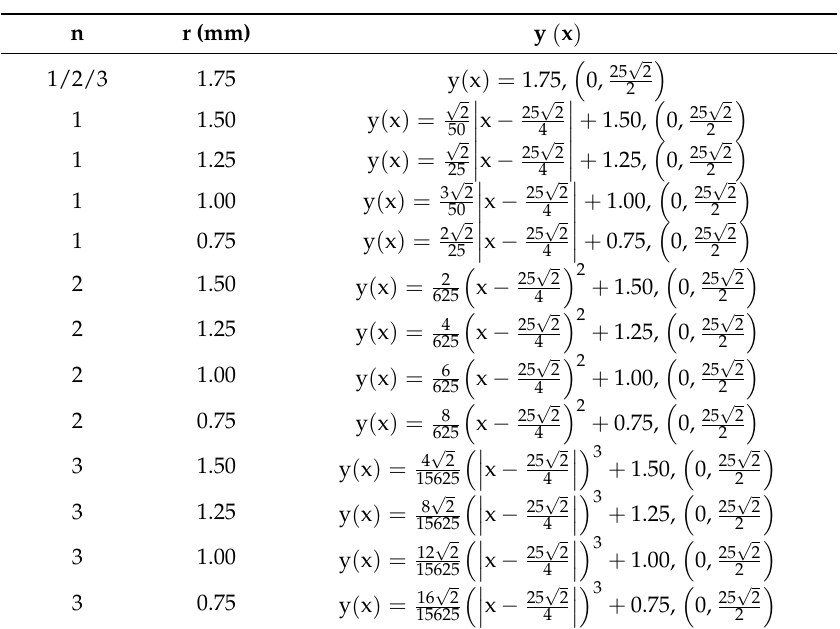
Table 1. Core cross-section functions.